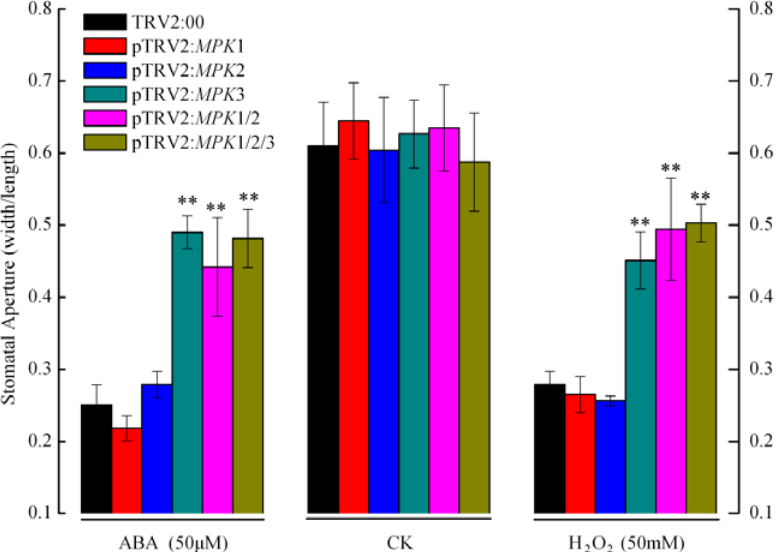
2. Stomatal apertures (the ratio of width to length) of gene-silenced plants in response to ABA and H O . Leaves of control, individual gene-silenced 2 2 ( SpMPK1 , SpMPK2 , or SpMPK3 ) and combined gene-silenced ( SpMPK1 / SpMPK2 or SpMPK1/SpMPK2 / SpMPK3 ) plants were incubated in stomatal opening solution for 2 h. Some of them were transferred to solutions containing 50 μM ABA or 50 mM H O for 2 h 2 2 and the others remained in the opening solution for control (CK). Stomata on the adaxial surface were observed by light microscopy. For each type of gene-silenced plants, at least 20 stomata from each sample of ten genes-silenced plants were measured. The data represent means ± SD. Asterisks indicate that the mean value is signficantly different from the control at p <